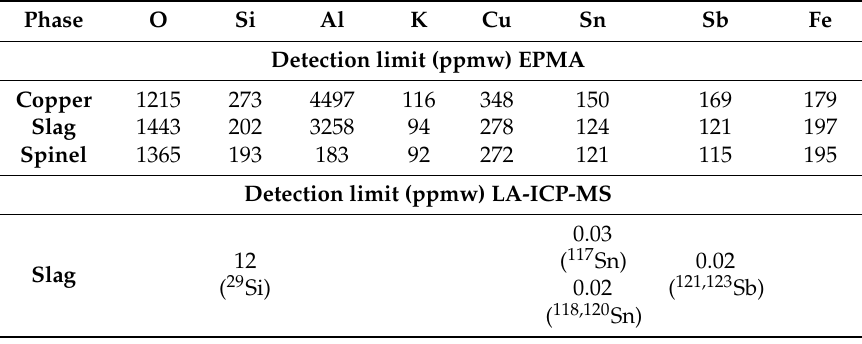
Table 1. EPMA and LA-ICP-MS elemental/isotopic detection limits for each phase analyzed. ppmw = parts per million by